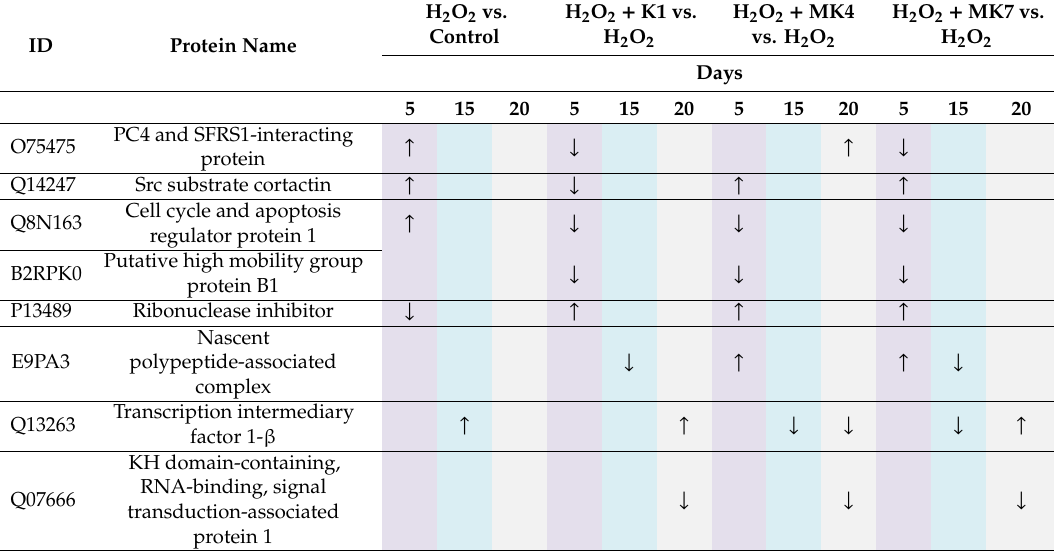
Table 2. The list of proteins with transcription regulator activity that expression was significant changed in osteoblasts treated with H 2 O 2 (200 µ M for 24 h) and K1, MK4, or MK7 (10 µ M for 5, 15, and 20 days). Arrows indicate the direction of statistically significant changes for individual proteins ( ↑ —upregulation, ↓ —downregulation). Mean value of three independent experiments with standard deviation (SD) for each protein are presented in Tables